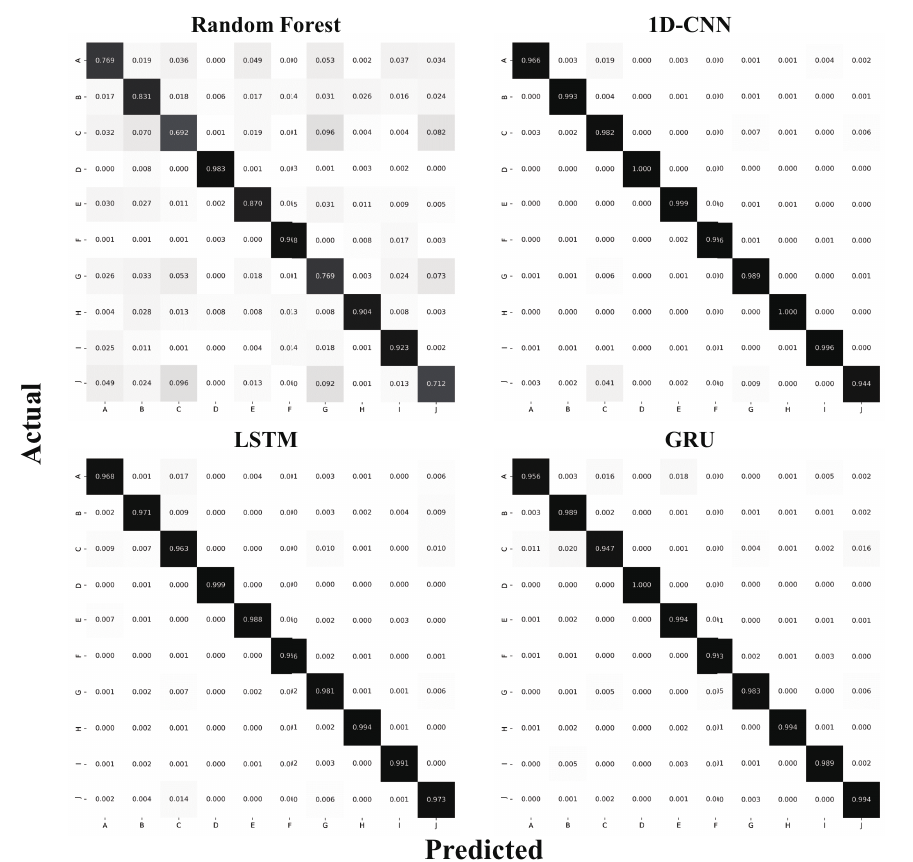
Figure 9. Confusion matrices of the classification results across all 10 class categories for the experiments using three input signals (X, Y, and Z) with loading & unloading window. The majority of misclassifications were between classes C (plywood wood table) and J (laminate